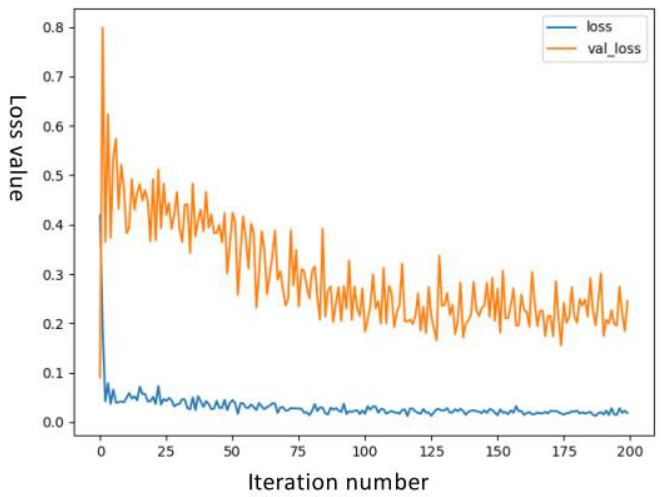
Figure 7. MSE on the training and validation sets.